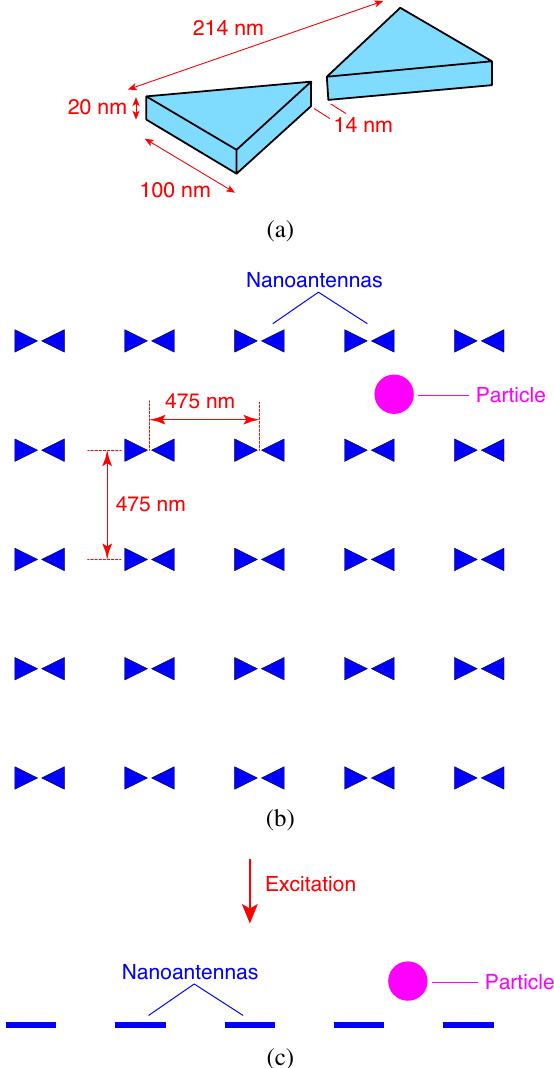
Figure 1: (a) The bowtie geometry for nanoantennas con- sidered in this paper. (b) An arrangement of 5 × 5 nanoan- tennas with 475 nm periodicity and a spherical particle lo- cated in the vicinity. (c) Side view of the 5 × 5 array and the particle located above it.